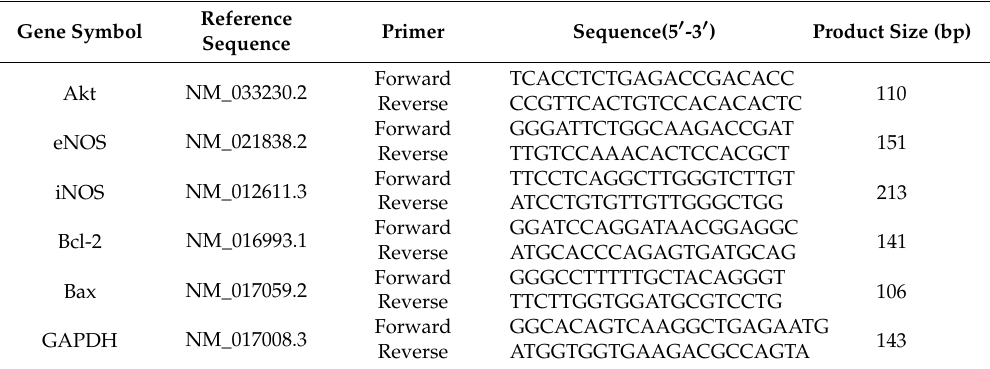
Table 1. Rat gene-specific